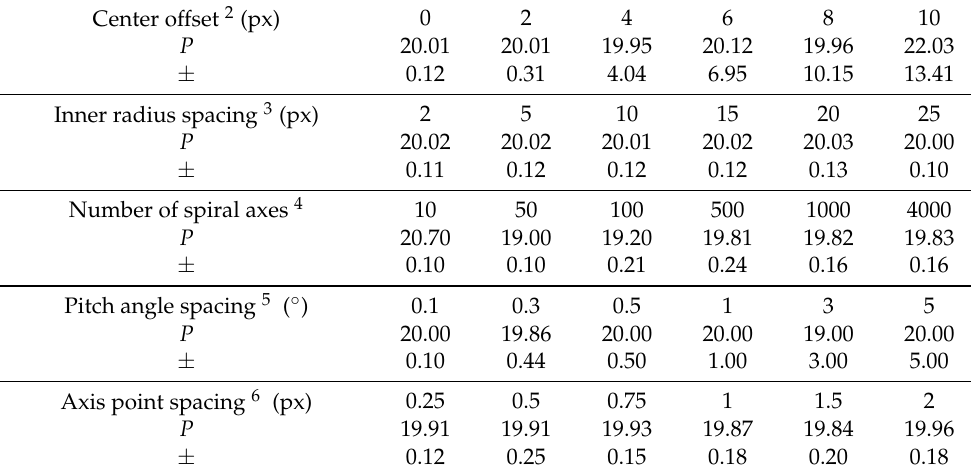
1 The optimal inputs are: center offset 0, inner radius spacing 10 pixels, 650 spiral axes, pitch angle spacing 0.1 ◦ , axis point spacing 0.1 pixels. 2 The number of pixels between the spiral’s true center and the center of the measurement annuli. 3 The number of pixels between inner radii of successive measurement annuli. 4 Number of spiral coordinate axes computed for each pitch angle template. 5 Number of degrees between successive pitch angle templates. 6 Number of pixels between successive computation points on a given spiral